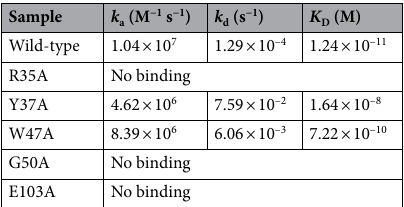
Table 2. Binding kinetics of anti-green fluorescent protein mutant nanobodies identified to have decreased affinities by peptide barcoding. These mutants were not fused with peptide